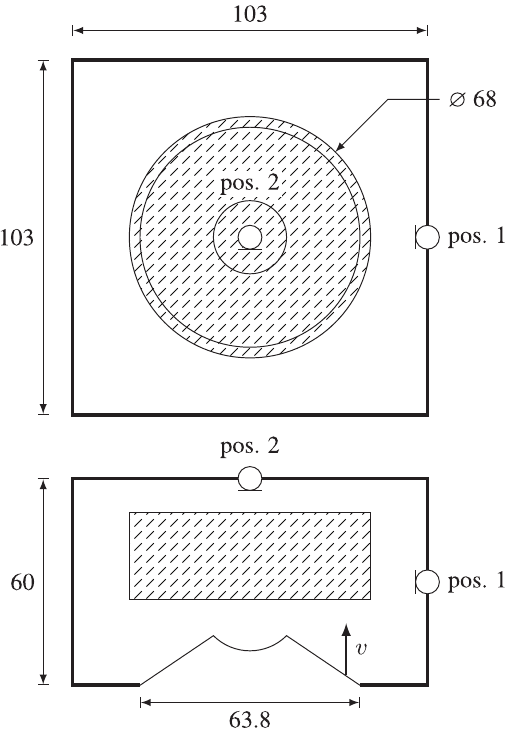
Figure 13. Simulated geometry, with the two microphones positions. Membrane is drawn in a thin line and the magnet is hatched. Units in